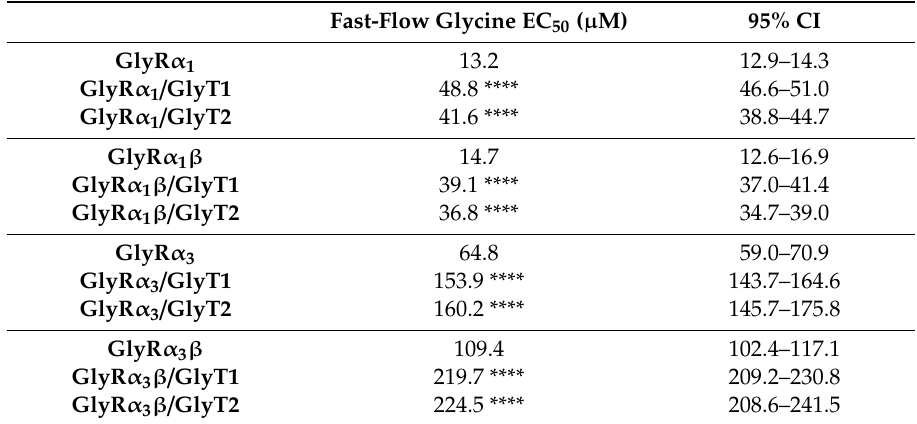
Table4. Fast-flowglycineEC 50 forGlyRandGlyR / GlyTco-expressedcellsusingdi ff